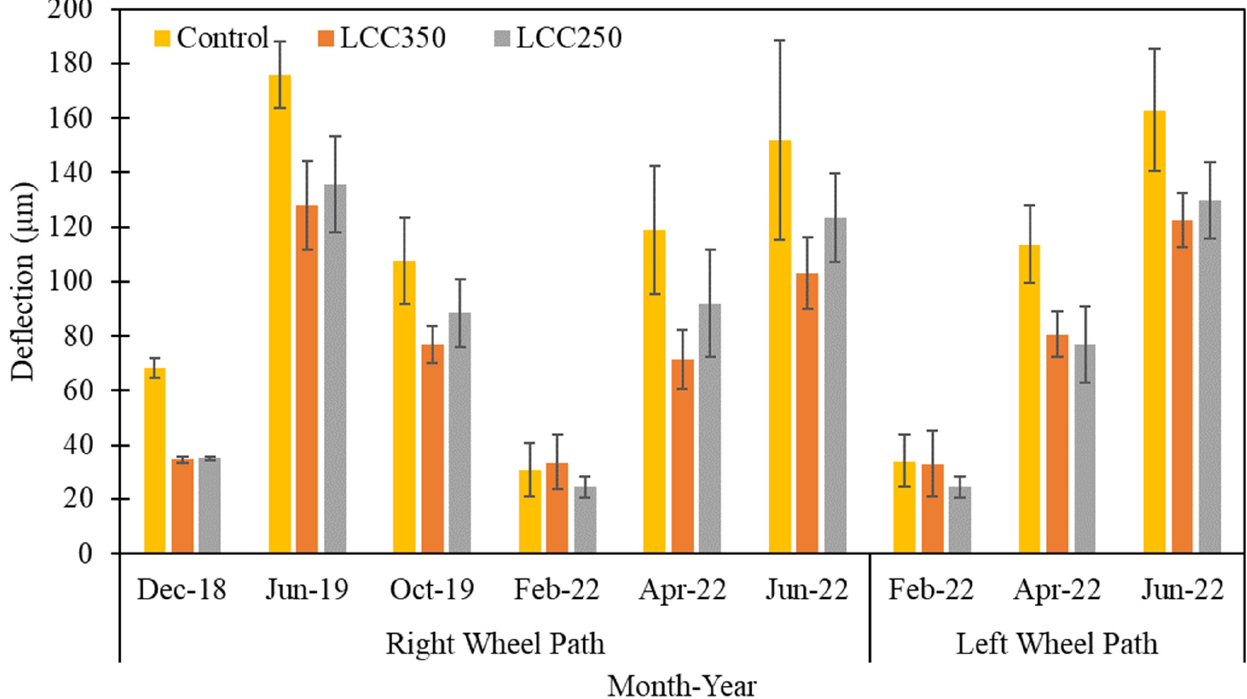
Figure 7. Erbsville LWD measured de fl ection.